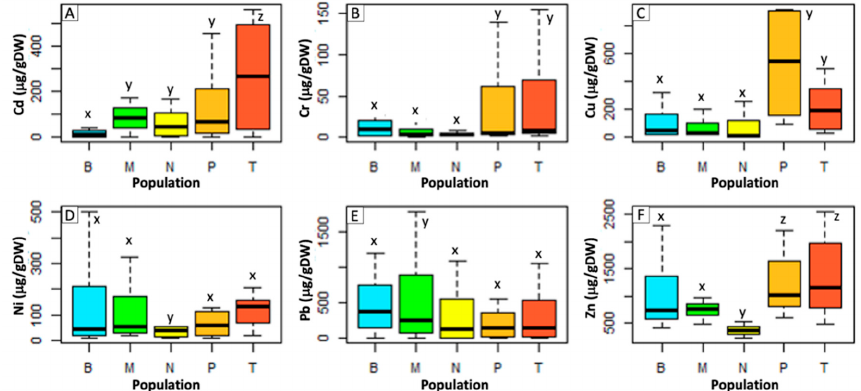
Figure 5. Shoot metal concentration in different P. aviculare populations. ( A ) Cd; ( B ) Cr; ( C ) Cu; ( D